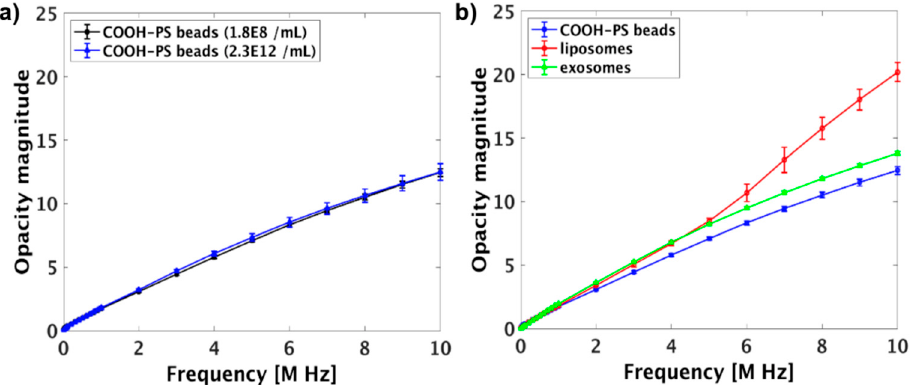
Figure 7. ( a ) The opacity magnitude of 100 nm COOH-PS beads with different entrapped quanti- ties. ( b ) Opacity magnitude of different particles suspended in 10 mM KCl. The error bars repre- of different particles suspended in 10 mM KCl. The error bars represent the standard deviation and each experiment was sent the standard deviation and each experiment was repeated at least three times. repeated at least three